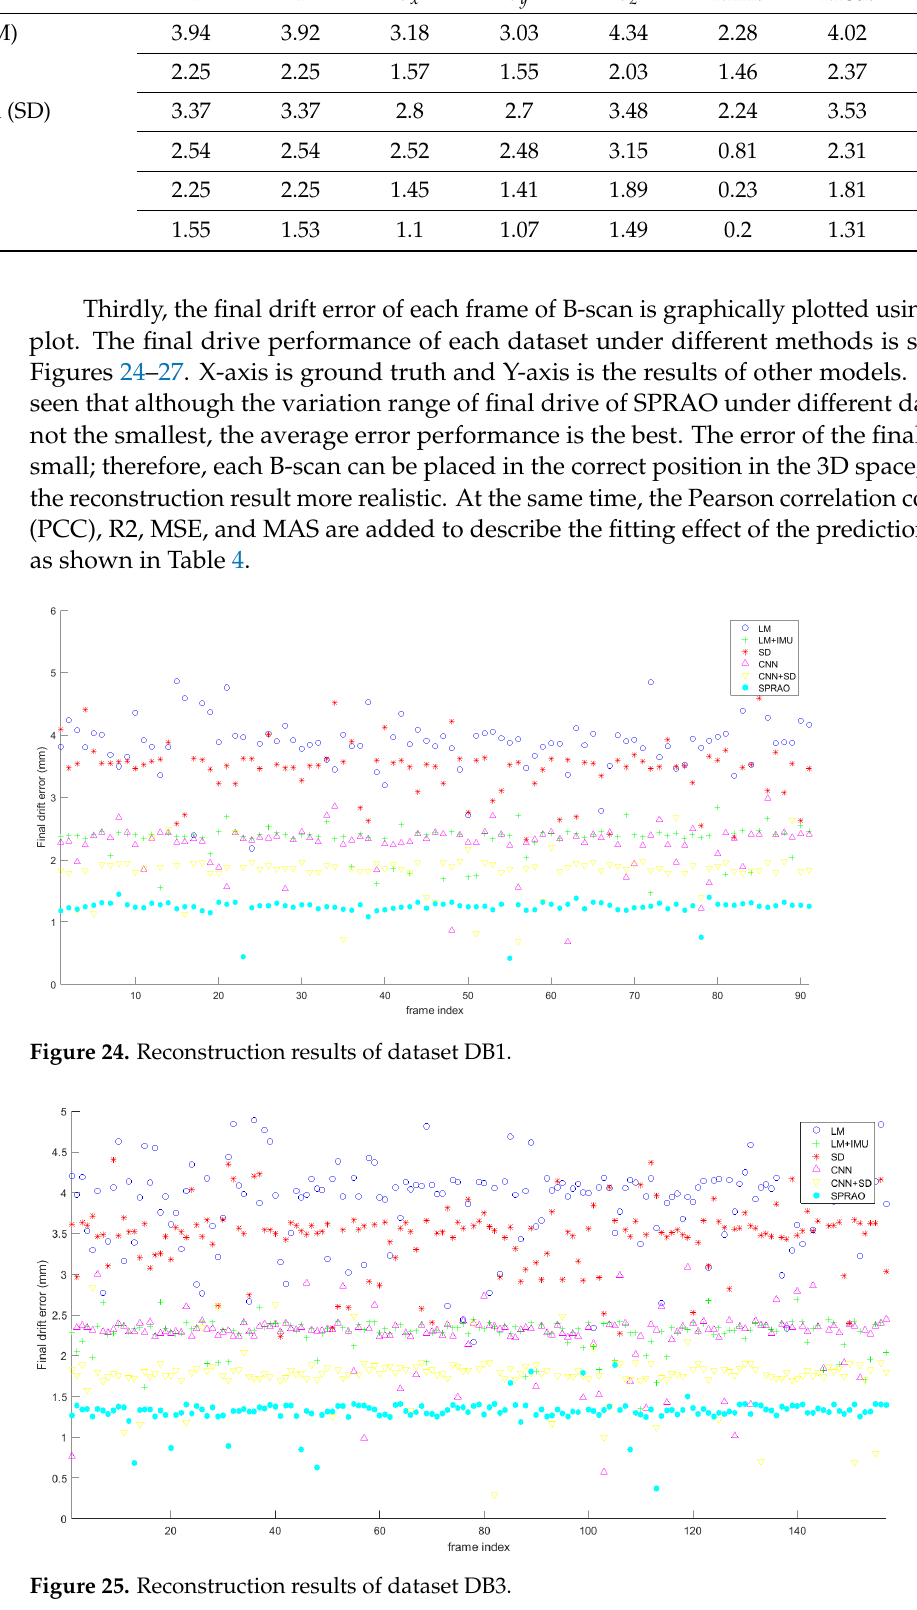
Figure 26. Reconstruction results of dataset DB5.